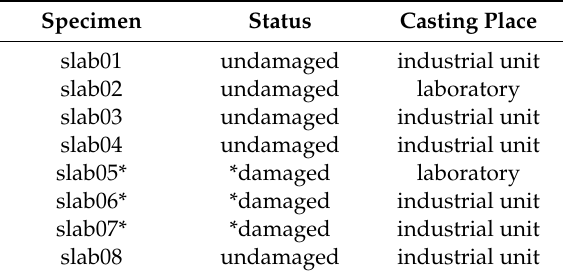
Table 2. Specimens characteristics summarization.